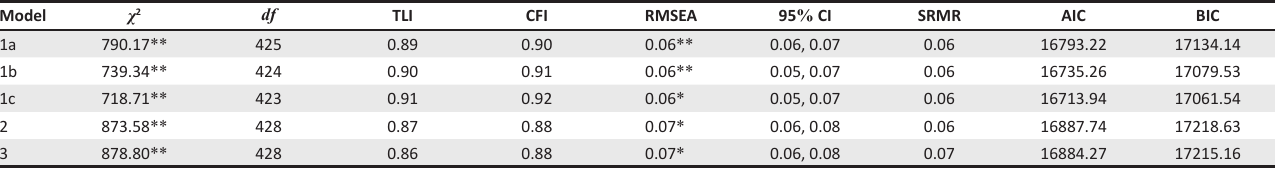
TABLE 1 : Fit statistics of competing measurement models. Model